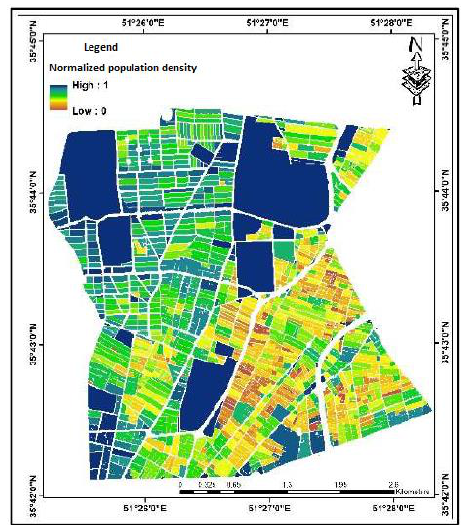
Figure 8. Fuzzified population